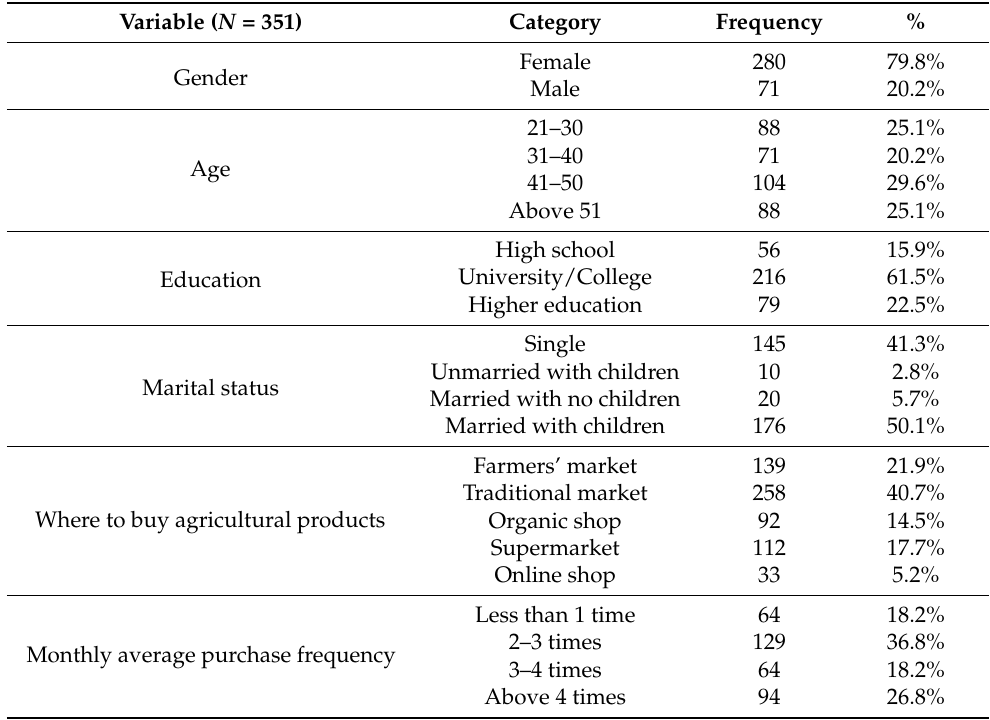
Table 1. Demographic